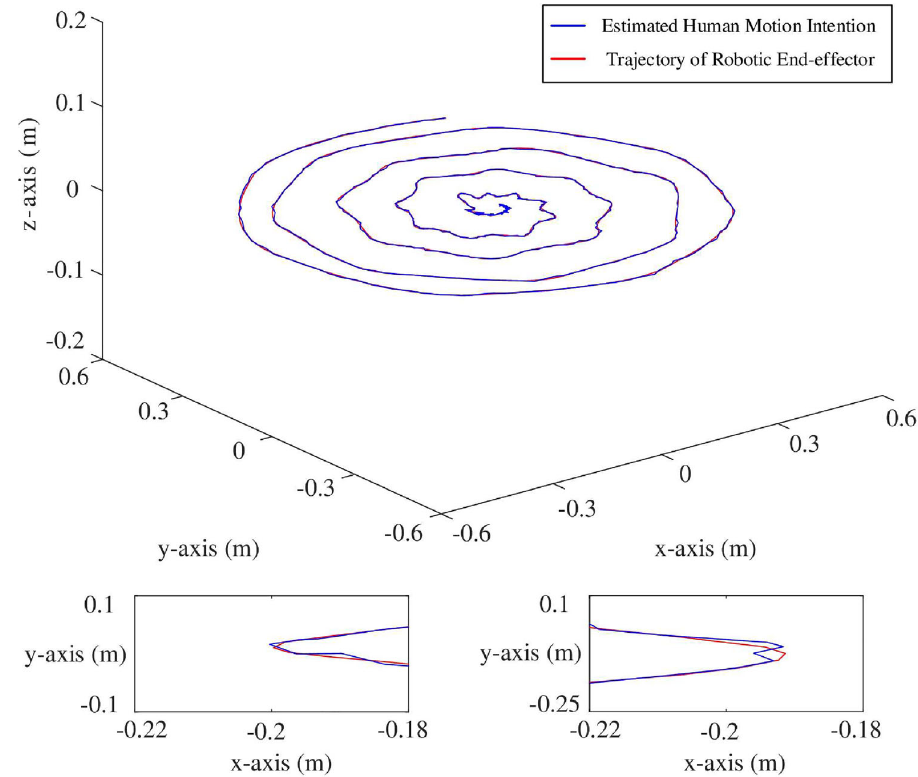
Fig. 6 Trajectory curves of human–robot interaction point in three-dimensional space under the proposed